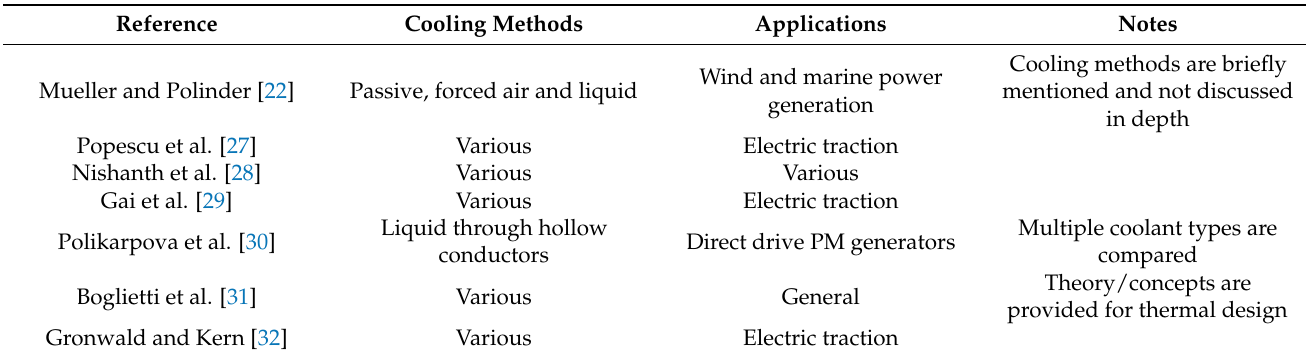
Table 1. Summary of literature review